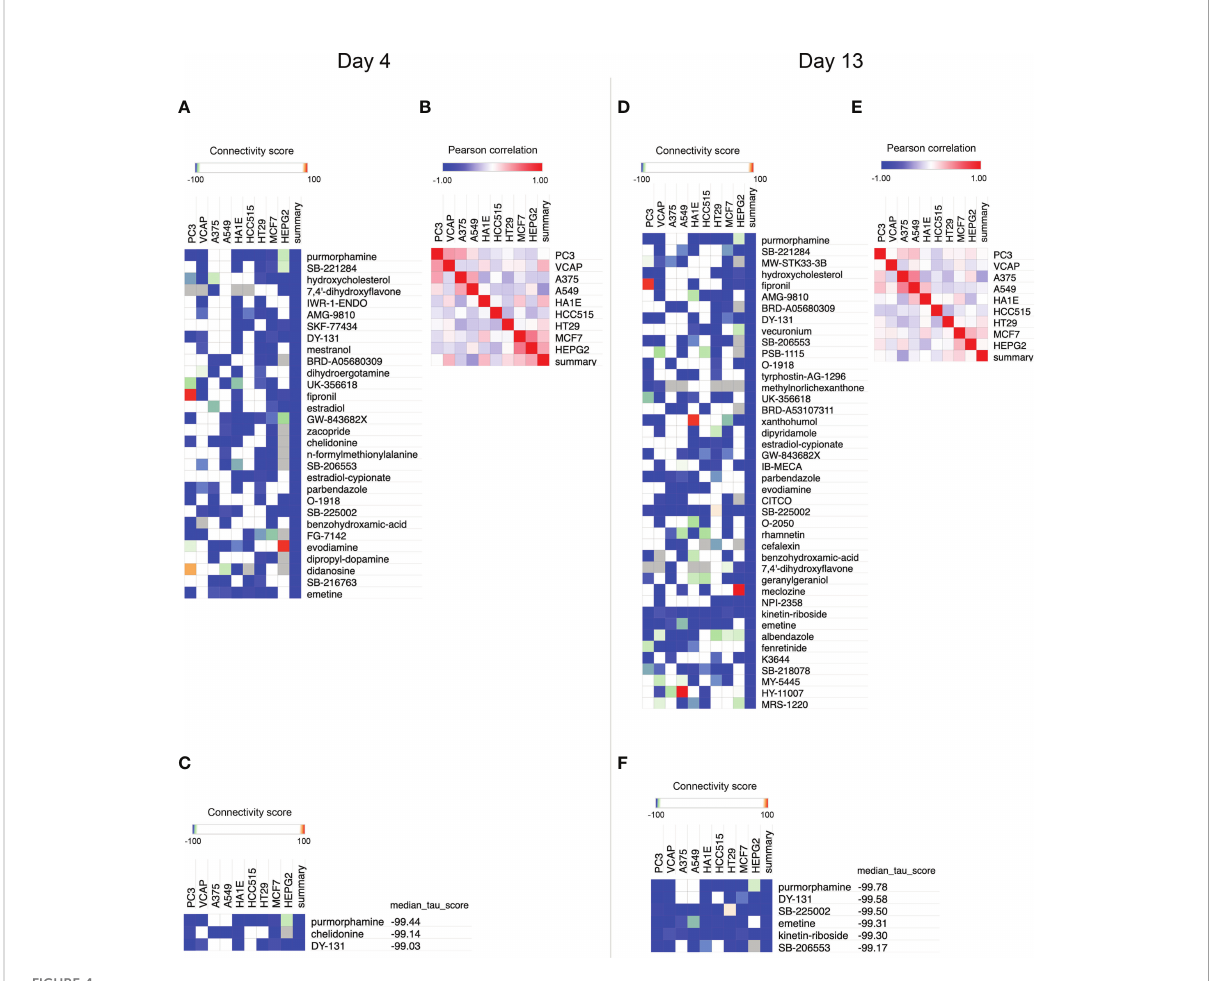
FIGURE 4 Small molecule-prioritization from CMap query (A) Heatmap showing compounds with a summary score less than -99 using differentially expressed (DE) probes of microarray data derived from adipogenic-BMSCs at day 4. (B) Expression similarities among different cell lines are indicated at day 4. (C) Compounds with a connectivity score and a summary score less than -99 were identi fi ed using microarray data at day 4. (D) Heatmap showing compounds with a summary score less than -99 using DE probes of microarray data derived from adipogenic-BMSCs at day 13. (E) Expression similarities among different cell lines were indicated at day 13. (F) Compounds with a connectivity score and a summary score less than -99 were identi fi ed using microarray data at day 13. Compounds were sorted by ascending order of median connectivity (tau) score in (C) and (F) .